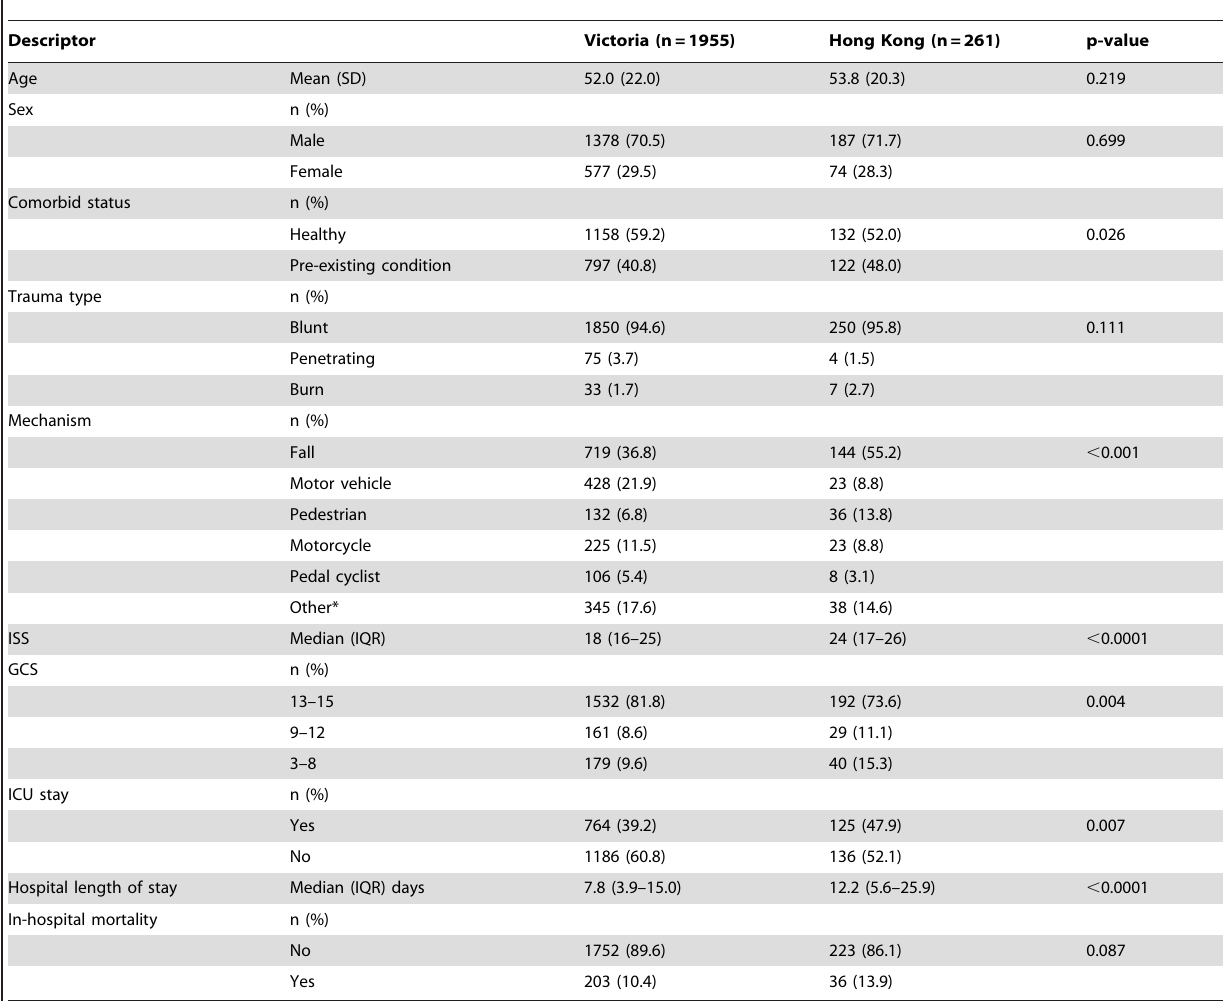
Table 1. Characteristics of major trauma survivors to hospital discharge in Hong Kong and